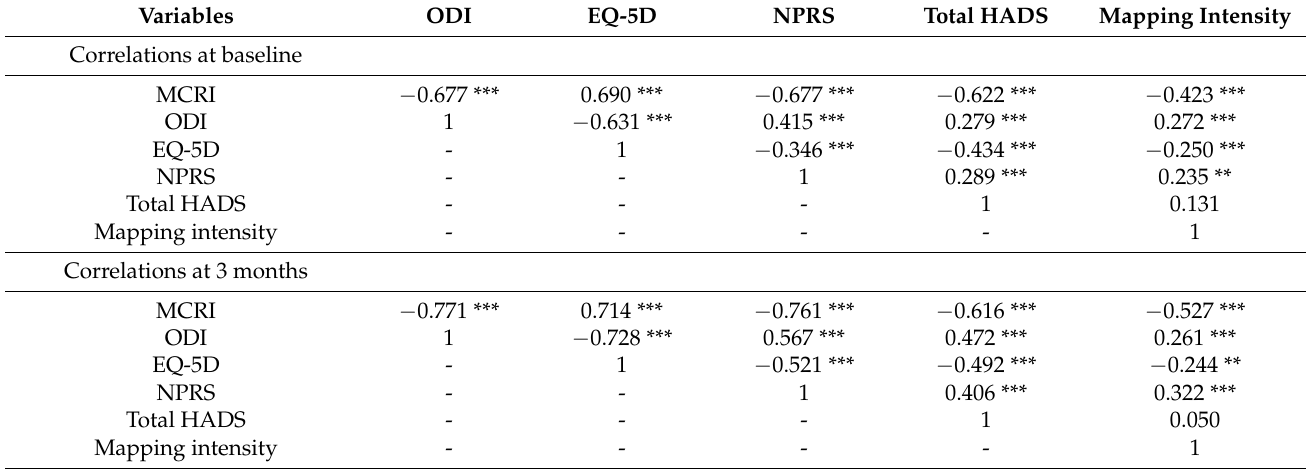
Table 6. Correlation matrix of the MCRI, ODI score, EQ-5D index, total HADS score and mapping intensity at M0, M3, M6, M9 and M12